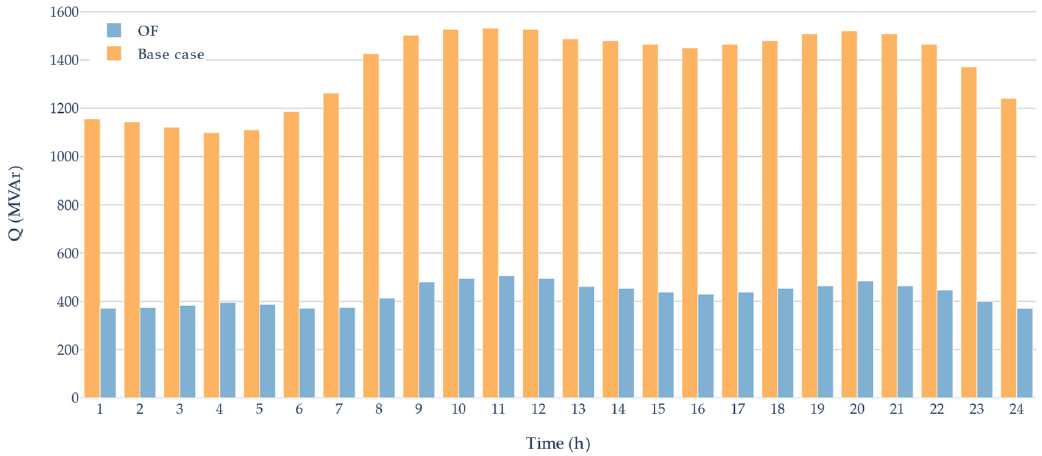
Figure 9. Absolute reactive power output of generators for each period for the IEEE 118-bus test system.